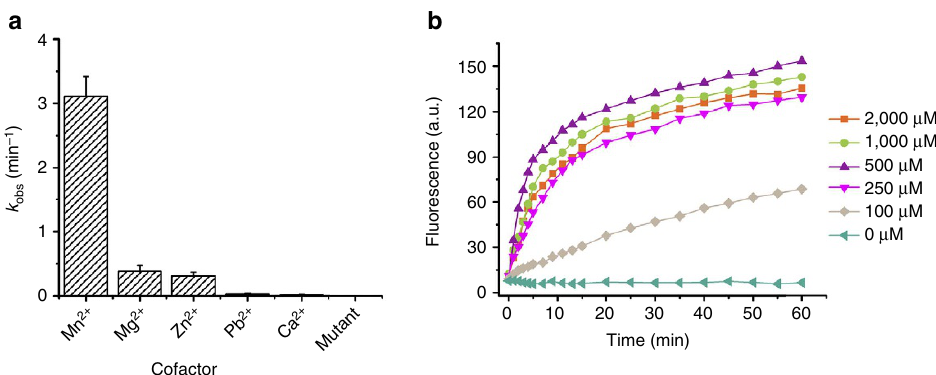
Figure 3 | Effect of the cofactors on the operation of the DNAzyme motor. ( a ) Multiple-turnover cleavage rate ( k obs ) of the DNAzyme motor tested using 200pM target DNA and different divalent metal ions as cofactors. The concentrations of metal ions were 0.5mM Mn 2 þ , 10mM Mg 2 þ and Ca 2 þ , 0.01mM Zn 2 þ and 0.2mM Pb 2 þ . A mutant DNAzyme motor (sequence in Supplementary Table 1) was also tested using 200pM target DNA and 0.5mM Mn 2 þ . Error bars represent 1 s.d. from duplicate experiments. ( b ) Real-time fluorescence generated by the DNAzyme motor that was initiated by 200pM target DNA and activated by different concentrations of the cofactor Mn 2 þ . The RSDs